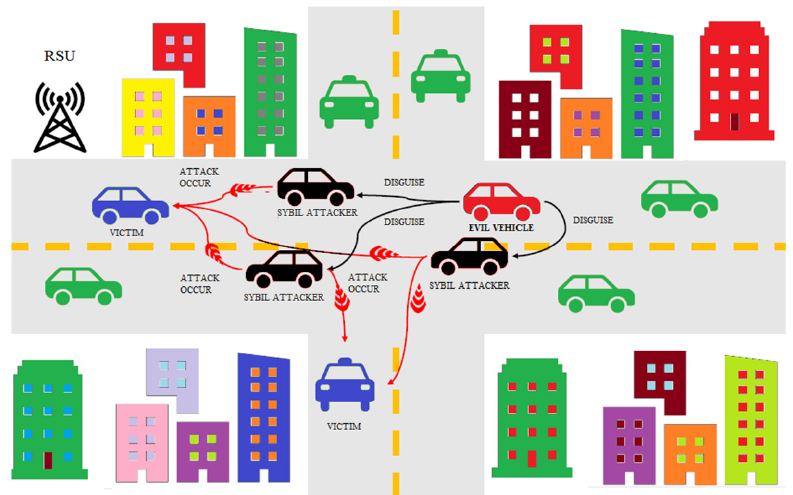
Figure 5. Sybil Attack Model [31].